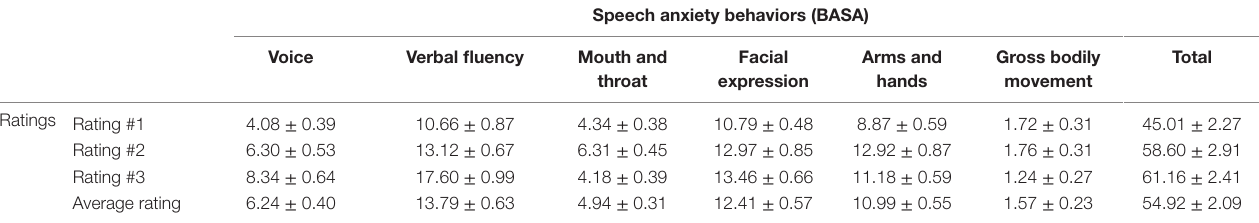
TaBle 1 | anxiety behavior ratings based on the Behavioral assessment of speech anxiety